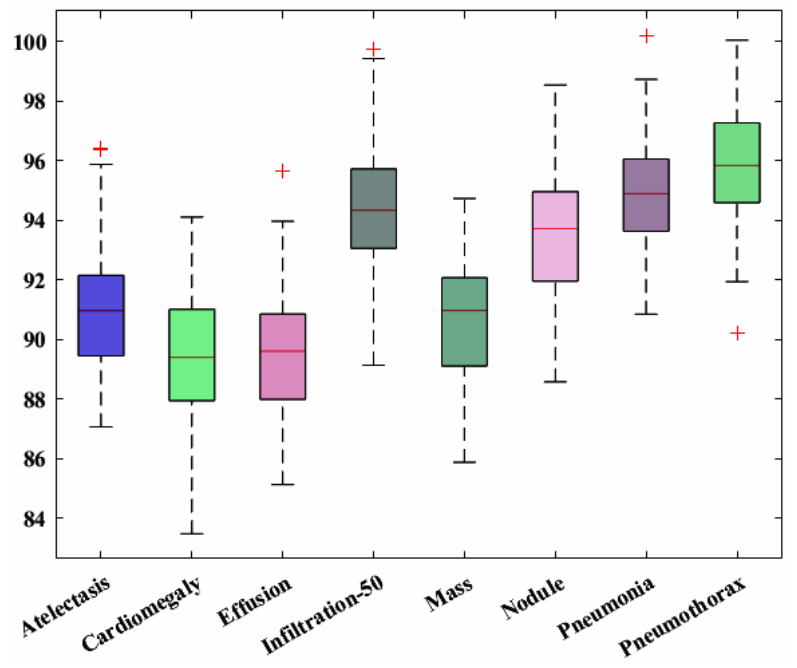
Figure 8 . Category-wise precision score for the CXray-EffDet model . Figure 8. Category-wise precision score for the CXray-EffDet model.